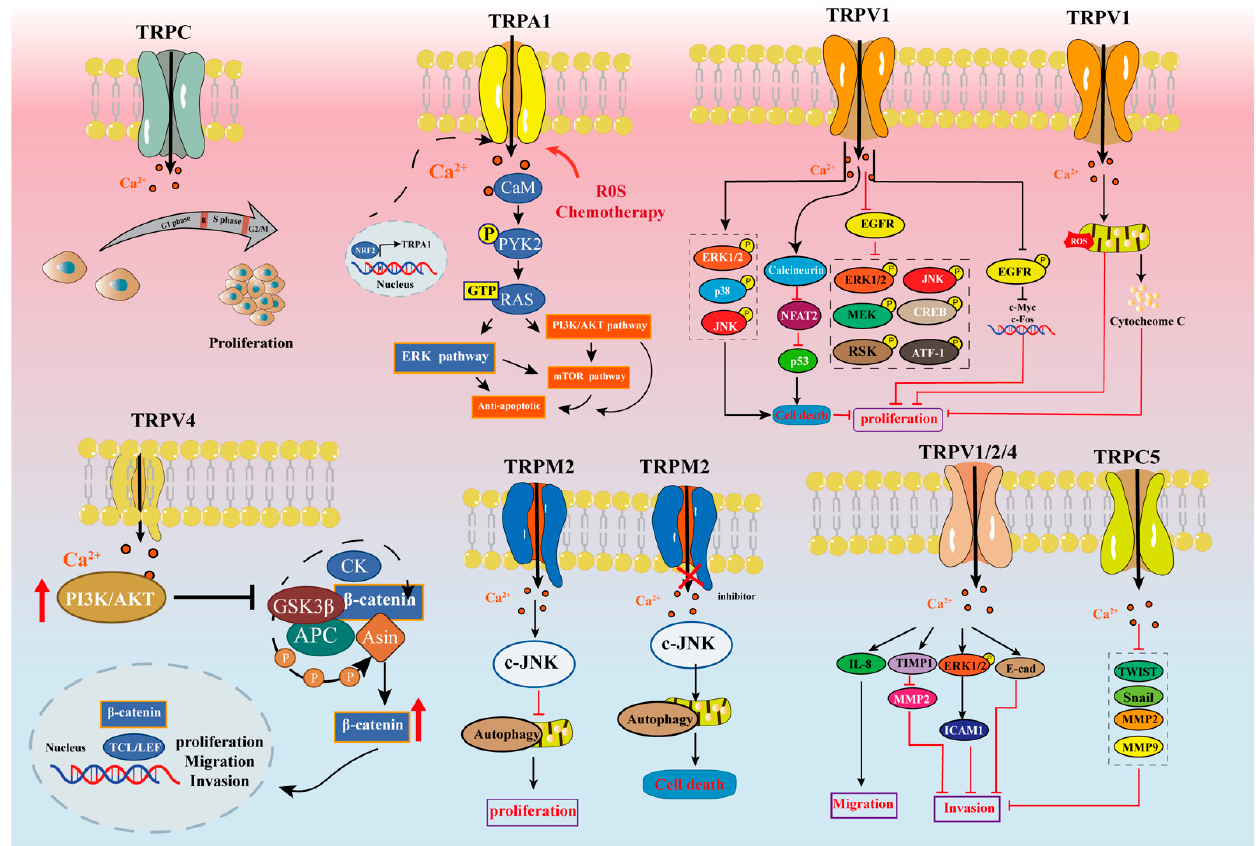
Figure 4. Mechanism of gastric cancer proliferation, invasion and metastasis mediated by representative thermo-TRPs.